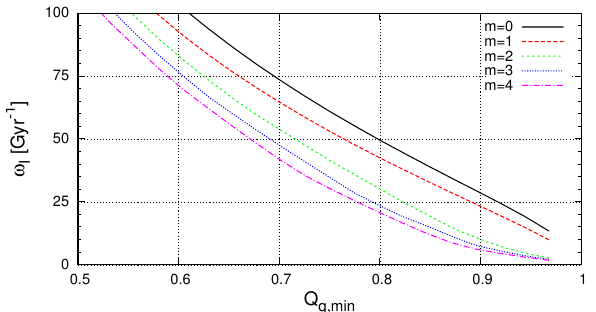
Figure 3. The growth rate of the perturbations with the number of arms m = 0...4 as a function of the minimum value of Q